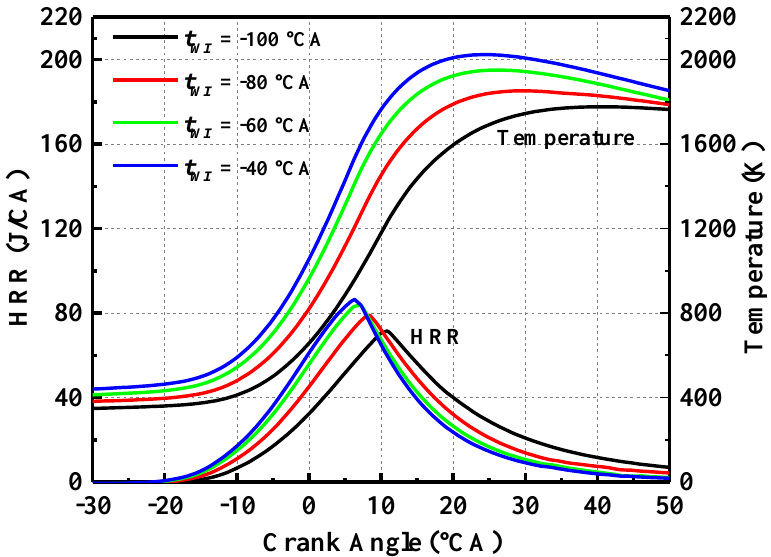
Figure 15. Effects of 𝑡 𝑊𝐼 on HRR and in-cylinder temperature (GDI; 𝑅 𝑤𝑓 = 1.0).